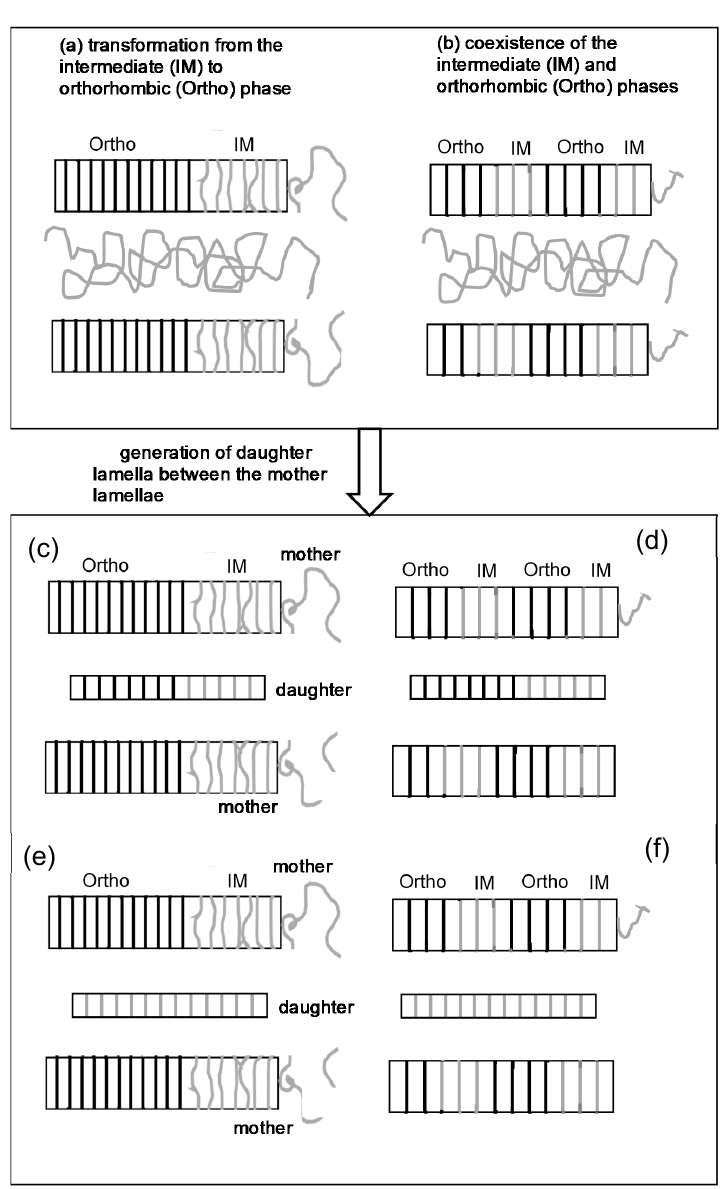
Figure 11. ( a,b ) The distribution of the intermediate and regular crystalline phases in the growing lamella. ( c–f ) The generation of the daughter lamella between the original mother lamellae.